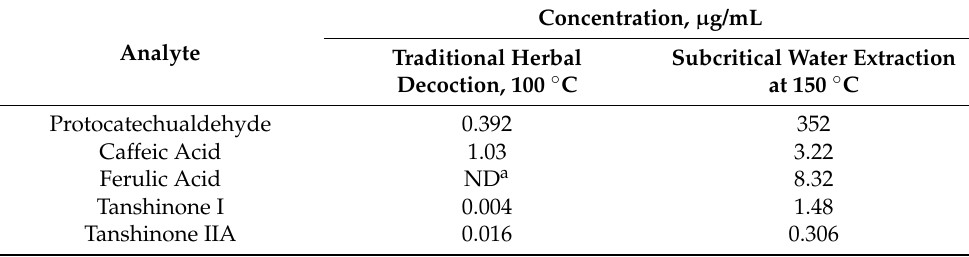
Table 2. Concentration of API in Salvia miltiorrhiza extracts used for reproduction